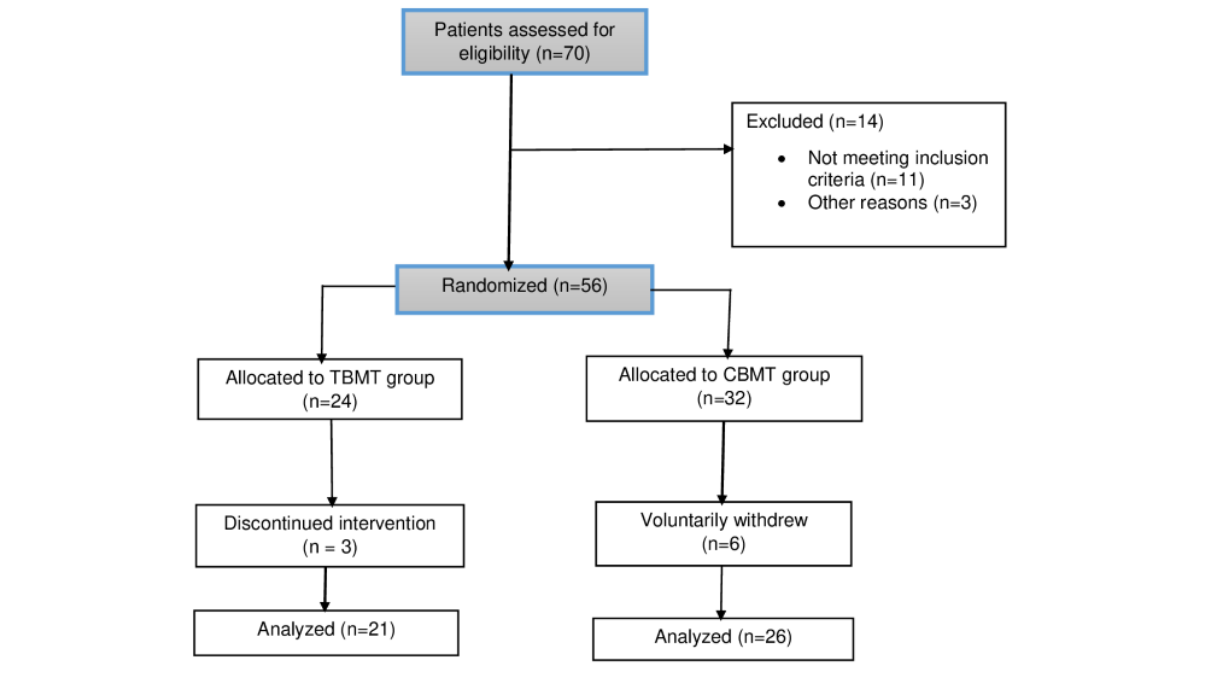
Figure 1. Flowchart of included patients. CBMT: clinic-based McKenzie therapy; TBMT: telerehabilitation-based McKenzie therapy.